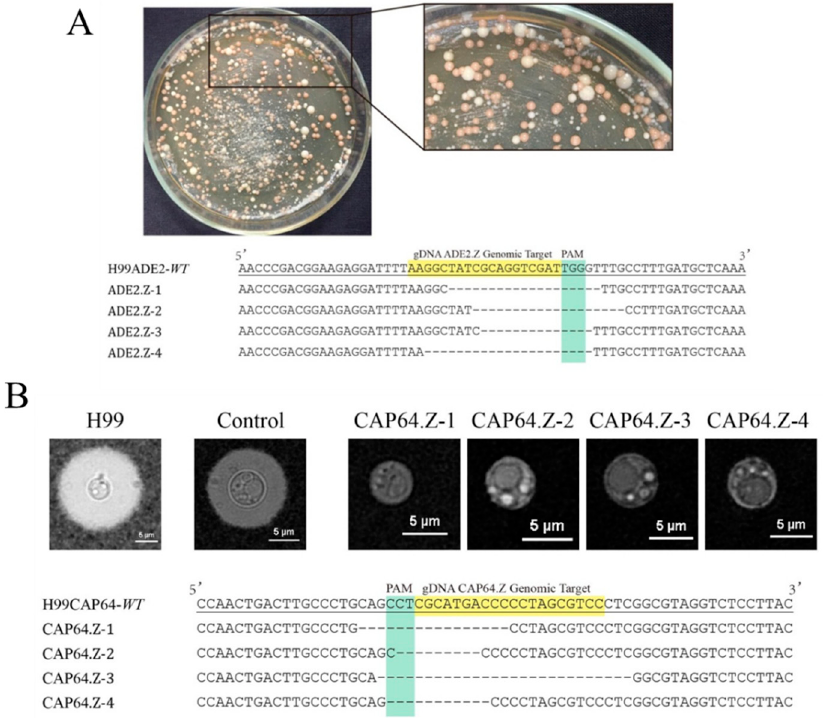
Figure 2. Target gene mutagenesis with the all-in-one CRISPR-Cas9 system expressed by the pNK003 vector. ( A ) ADE2 mutagenesis was mediated by the pNK003/ADE2.Z plasmid in the H99 strain. The ADE2 -deficient transformants exhibited pink clones on the YPD plate supplemented with 100 µ g mL − 1 hygromycin. Alignments of the ADE2 gene from four randomly selected pink colonies revealed indels in the sequences. H99ADE2-WT is the wild-type reference ADE2 gene sequence; ADE2.Z 1-4 are mutants from the population. The target and PAM sequence are highlighted. ( B ) CAP64 mutagenesis was created by the pNK003/CAP64.Z plasmid in the H99 strain. Alignments of the CAP64 gene from four randomly selected unoiled colonies revealed indels in the sequences. H99CAP64-WT is the wild-type reference CAP64 gene sequence; CAP64.Z 1-4 are mutants from the population. The target and PAM sequence are highlighted. The morphological anal- ysis of wild-type H99 cells and cap64 ∆ mutants confirmed the deficiency of CAP64 .